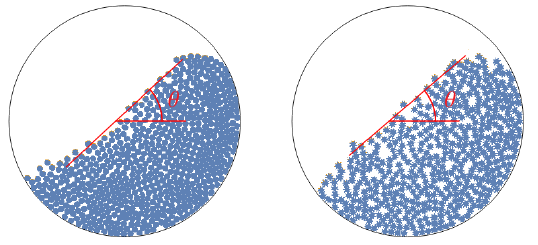
Figure 3. Measurement of the dynamic angle of repose θ for the disks (left) and the most irregular grains (right) on one binarized frame captured. A linear fit of the highest pixels detected on the surface (in orange) is calculated and the regression parameters directly give the desired angle. This method is repeated on each frame of the footage. The results are then averaged to obtain θ .